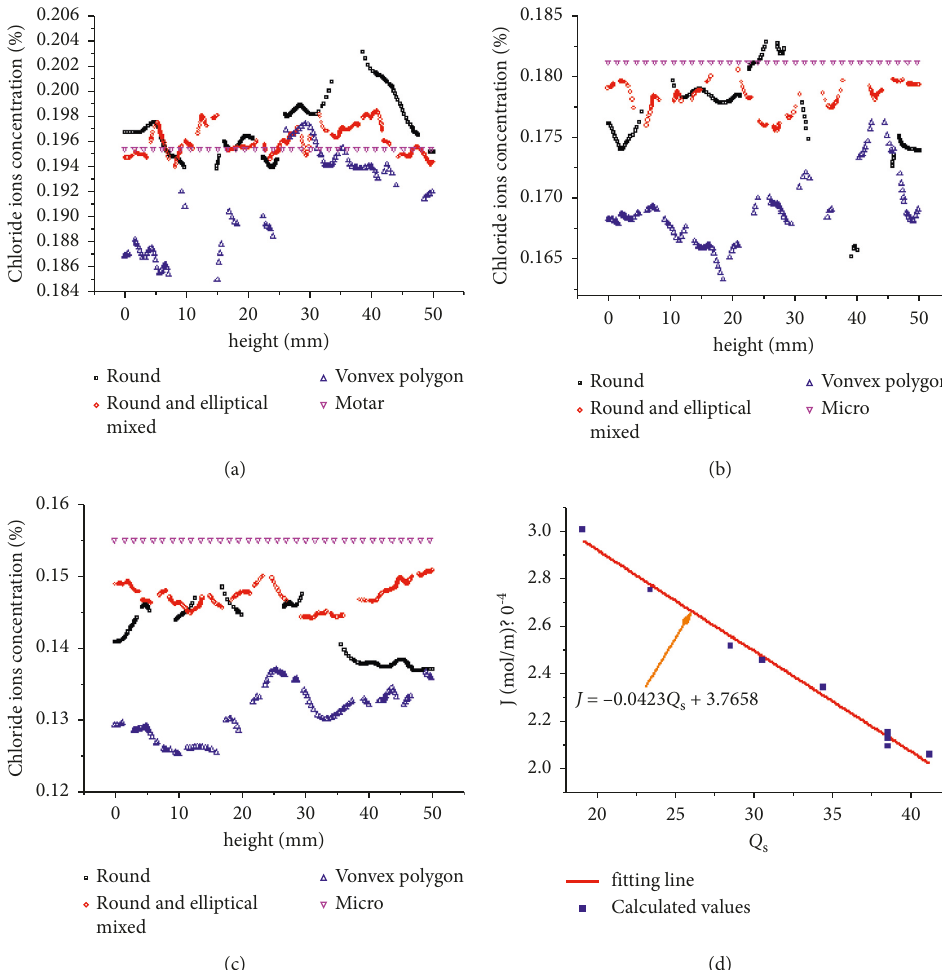
Figure 14: Chloride concentration distribution of different models at the same depth. (a) x � 5 mm; (b) x � 10mm; (c) x � 20 mm; (d) C - Q